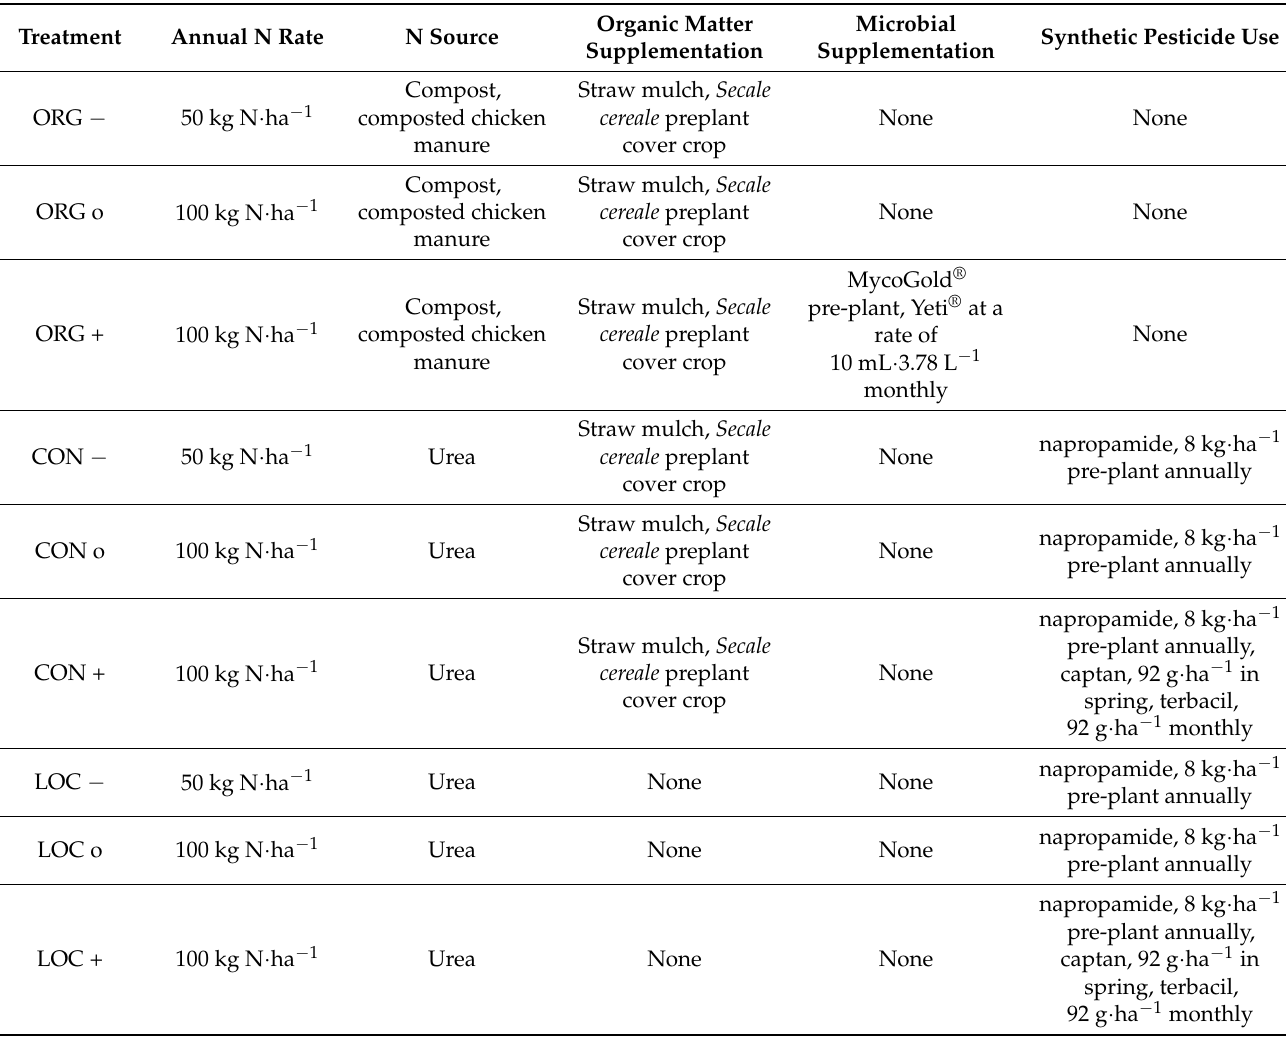
Table 1. Perennial matted row treatments for “Jewel” strawberry between Fall, 2017 and Spring, 2020 in Ithaca, NY. N = nitrogen. ORG = organic inputs, CON = conventional inputs, and LOC = low carbon inputs. ( − ) = low nitrogen fertilizer, (o) = recommended rate of N fertilizer, (+) = recommended rate of N fertilizer plus supplemental